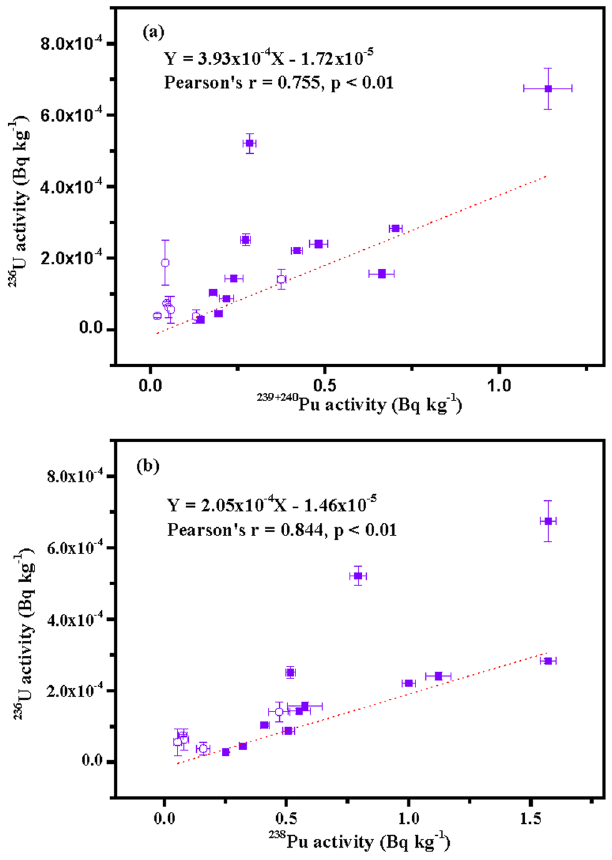
Figure 4. For the soil samples with a clear Pu contamination due to the FDNPP accident ( 240 Pu/ 239 Pu atom ratios, 0.245–0.312, and 238 Pu/ 239 + 240 Pu activity ratios, 0.859–1.62) in the present study (circle symbols), as well as black substances (square symbols) collected along roads in Fukushima Prefecture 10 , strong linear correlations were derived for: ( a ) 236 U activities and 239 + 240 Pu activities; and ( b ) 236 U activities and 238 Pu activities. Error bars on the sample values correspond to 1 σ .